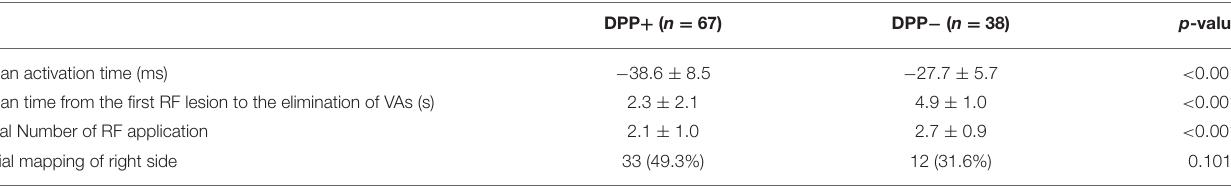
TABLE 3 | Electrophysiological characteristics during the VAs between patients with and without